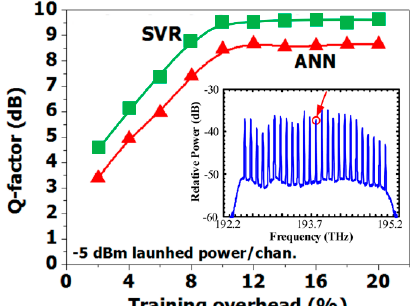
Figure 10. Training overhead evolution example at − 5 dBm of launched optical power (LOP) per channel for supervised support vector machine-regression (SVR) and artificial neural network (ANN). Inset: received optical spectrum of wavelength-division multiplexing (WDM) CO-OFDM system [22,28].